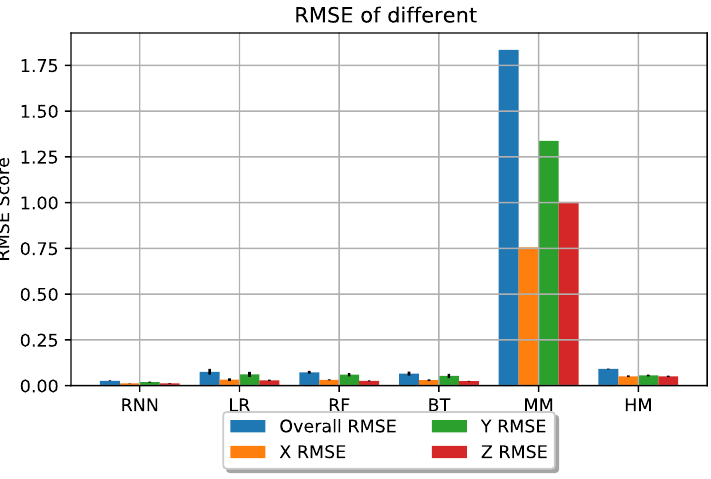
Figure 9. The best RMSE scores for data-driven models vs. the mathematical